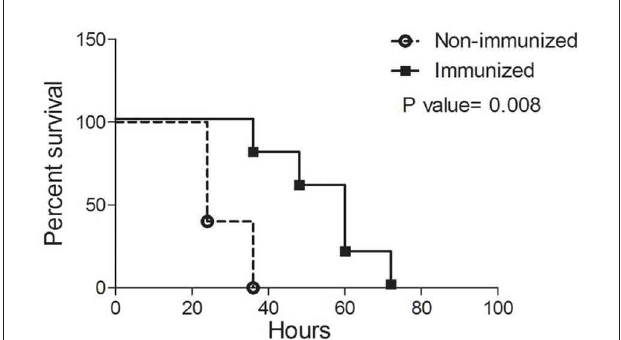
FIGURE 4 | Effect of immunization against PSMs on lethal sepsis/infectious endocarditis. Rabbits ( n = 4 or 5 per group) were either immunized against a cocktail of PSM α -1, PSM α -4, and PSM γ / δ -toxin (squares) or left unimmunized (circles). Aortic valves were then mechanically damaged, and rabbits were challenged with ∼ 10 7 CFUs of wildtype FRI1169 in the marginal ear veins. Rabbits were monitored for up to four days and were prematurely euthanized if displayed signs predictive of lethal illness. P -value determined by log rank test.